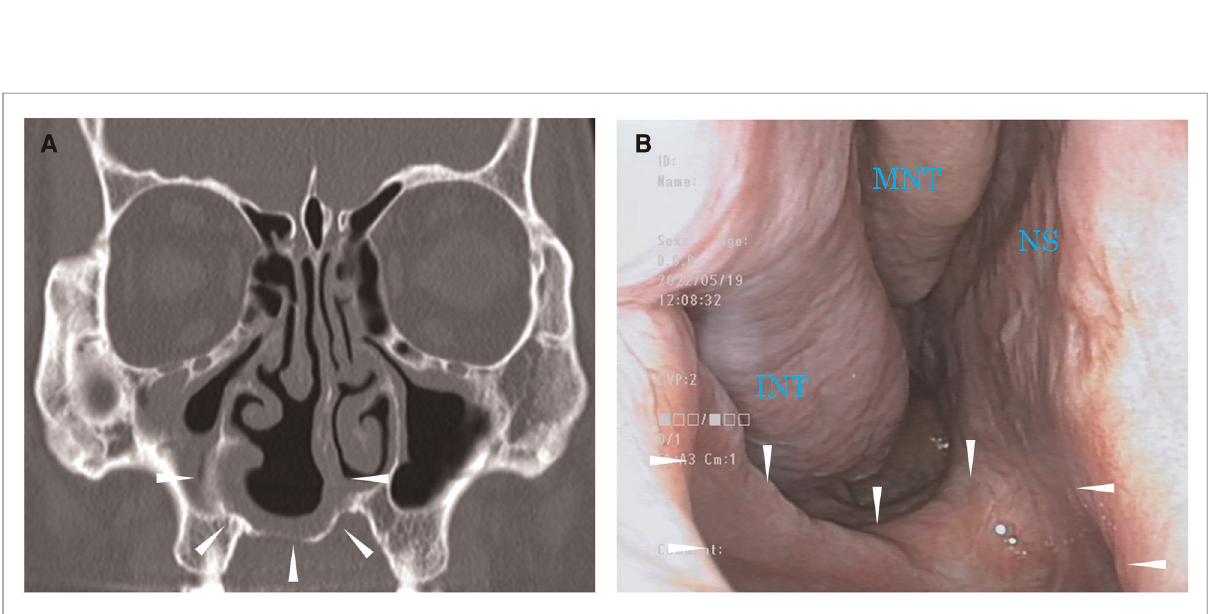
FIGURE 4 Images 3 months after surgery. The area surrounded by the arrowhead indicates a surgically opened area. ( A ) CT scan of the sinuses. ( B ) Endoscopic image of the right nasal cavity. CT, computed tomography; INT, inferior nasal turbinate; MNT, middle nasal turbinate; NS, nasal